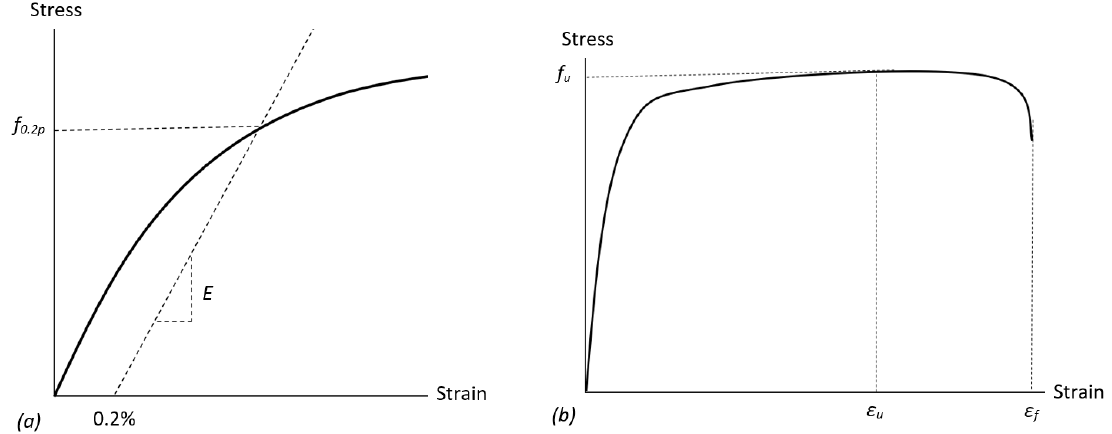
Figure 1. Idealised stress – strain response of austenitic stainless steel reinforcement, including ( a ) a focused view of the initial part of the curve and ( b ) the complete behaviour.